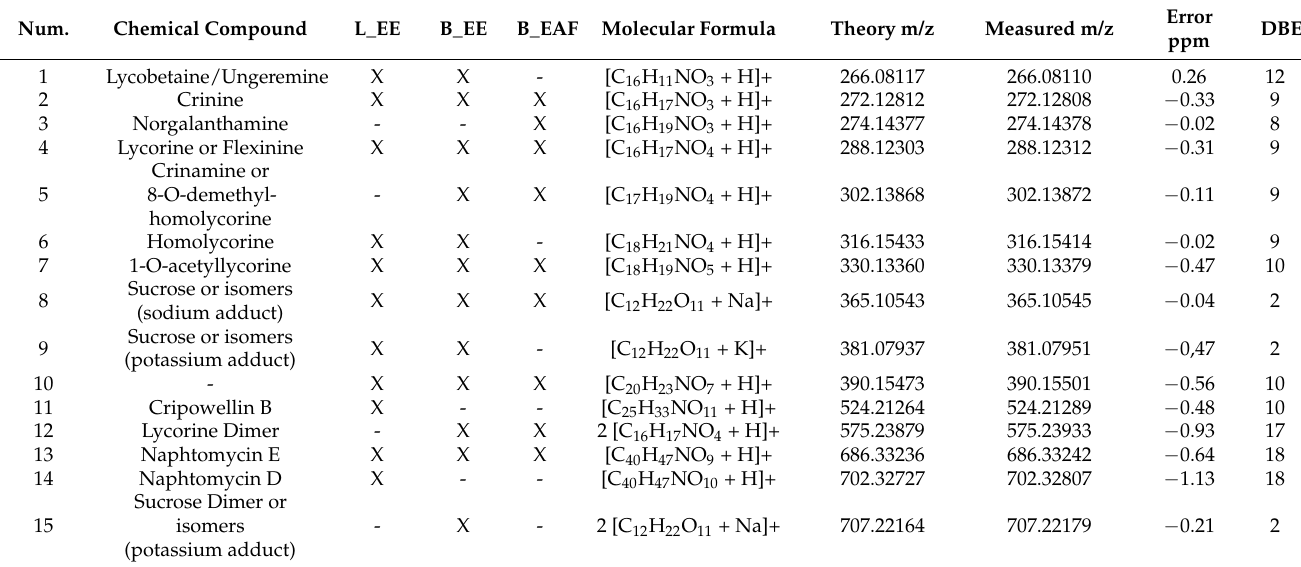
Table 2. Identification of the alkaloids by ESI (+) FT-ICR MS in the extracts from leaves (L_EE), bulbs (B_EE), and ethyl acetate fraction of bulbs (B_EAF) from Crinum americanum L.